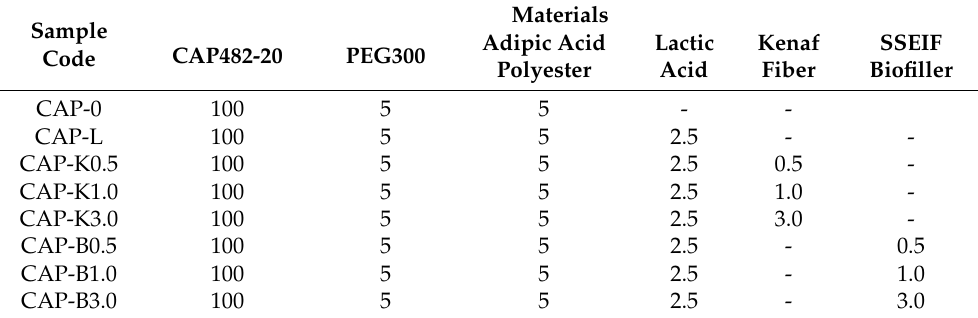
Table 2. Preparation of CAP–biofiller composite.